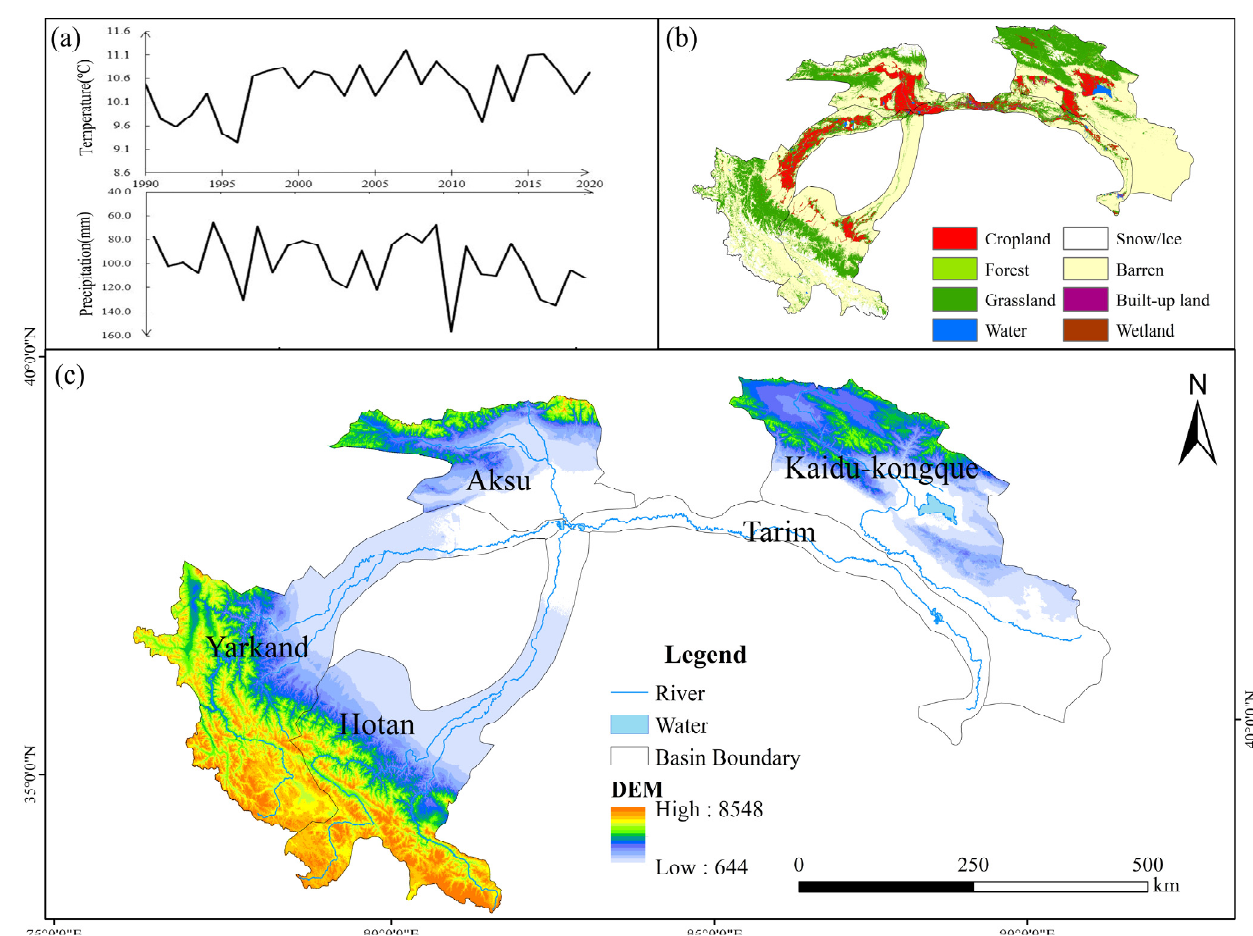
Figure 1. Overview map of the TRB (No. GS(2020)4619).( a ) Changes in average annual temperature and precipitation in the TRB from 1990 to 2020; ( b ) Distribution of land use types in the TRB; ( c ) Topography and distribution of rivers in the TRB.